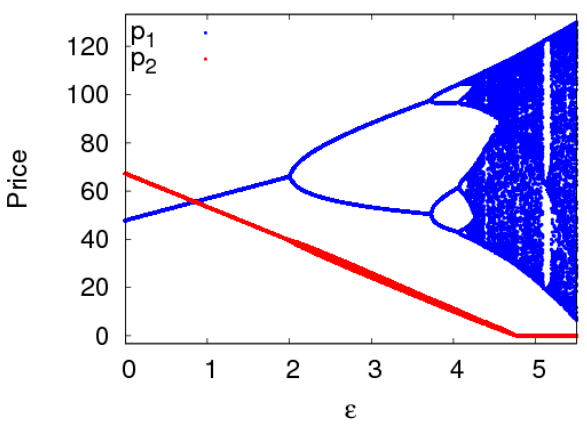
Figure 10. The bifurcation diagram of the dynamic system (6) with 𝜀 changing when 𝑎 (cid:2869) = 𝑎 (cid:2870) = 0.005 .